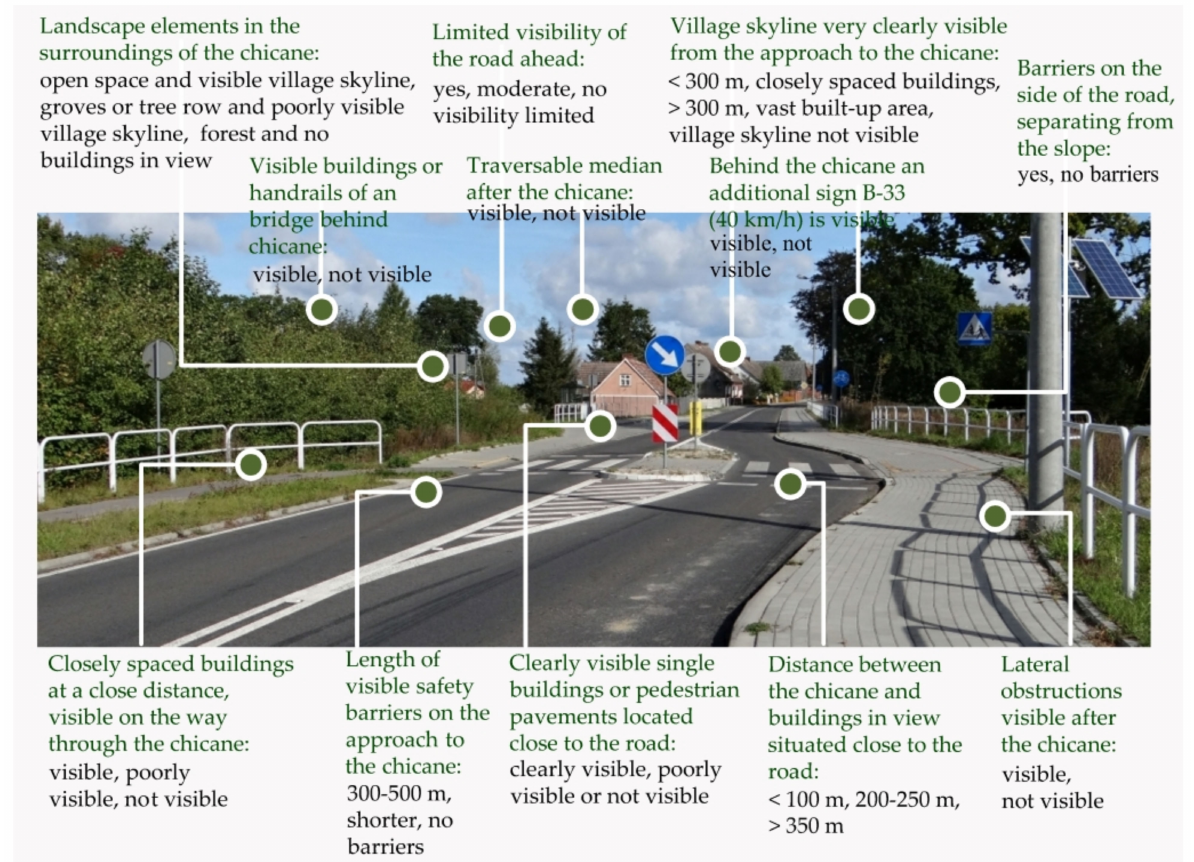
Figure 10. Factors selected for analyses, along with the assigned quantitative measures, related to the adjacent roadside development and visibility conditions, against the background image of test section No. 1. Green font designates qualitative factors and black font designates the adopted interpretation of the quantitative measure in